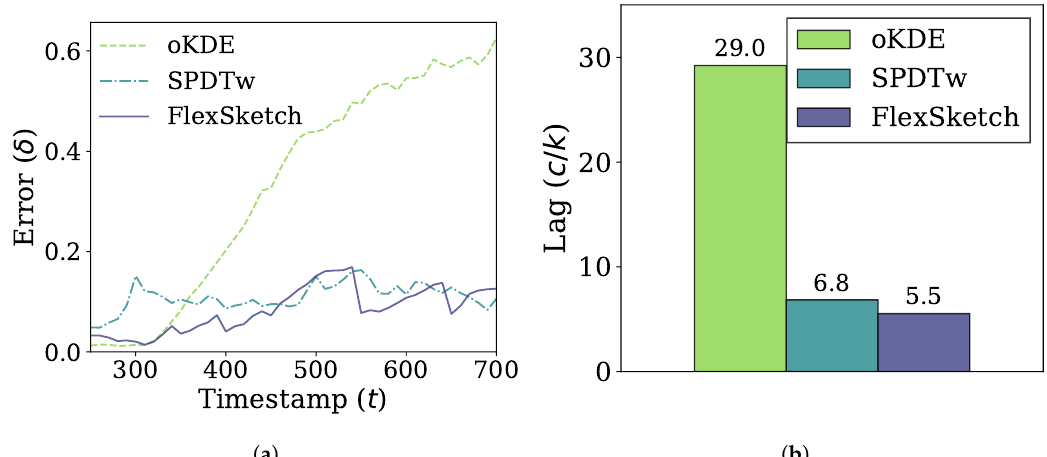
Figure 7. Error and adaptability performance under incremental concept drift. ( a ) Change of the error over time. ( b ) Lag (a smaller value is better).